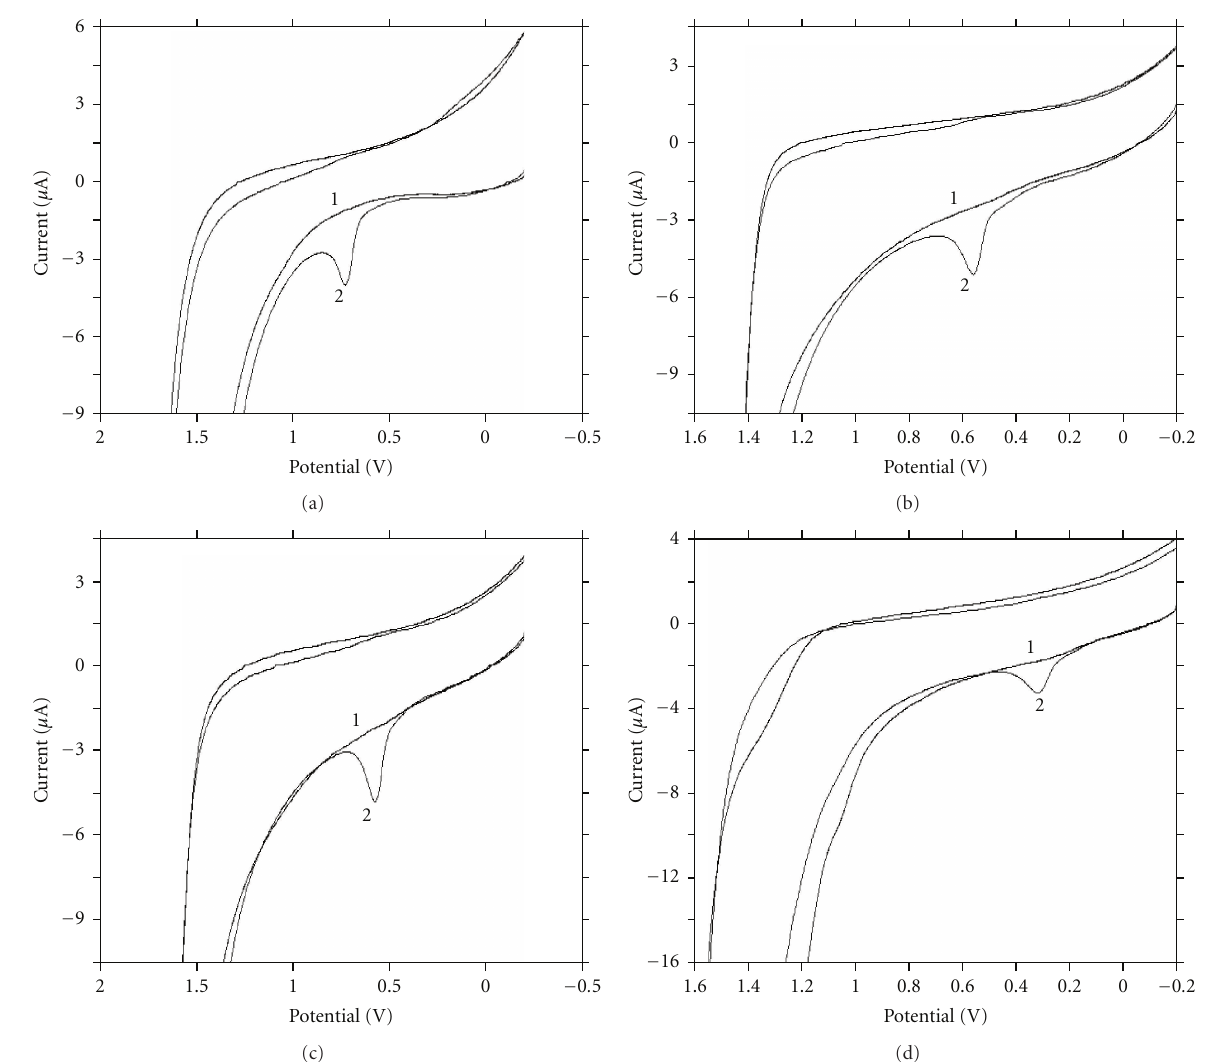
Figure 2: Cyclic voltammograms of supporting electrolyte (1) and 8 × 10 − 5 M fulvestrant (2) on GC electrode. (a) pH 2.0 phosphate bu ff er; (b) pH 4.5 acetate bu ff er; (c) pH 5.0 BR bu ff er; (d) pH 9.0 BR bu ff er